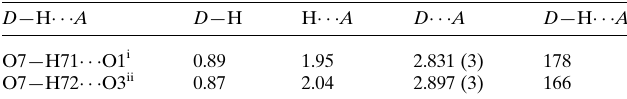
Table 2 Hydrogen-bond geometry (A˚ , (cid:5) ) for (I).